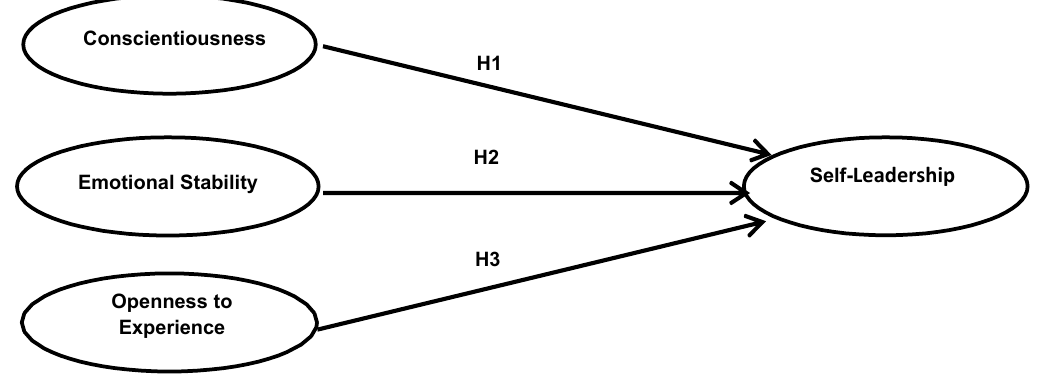
Fig. 1: Personality traits and Fig. 1 : Personality traits and self-leadership